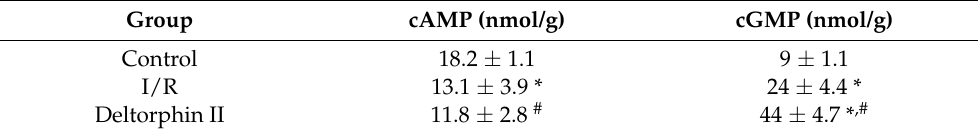
Table 2. Effect of deltorphin II on the cAMP and cGMP levels in ischemia/reperfusion of the heart.